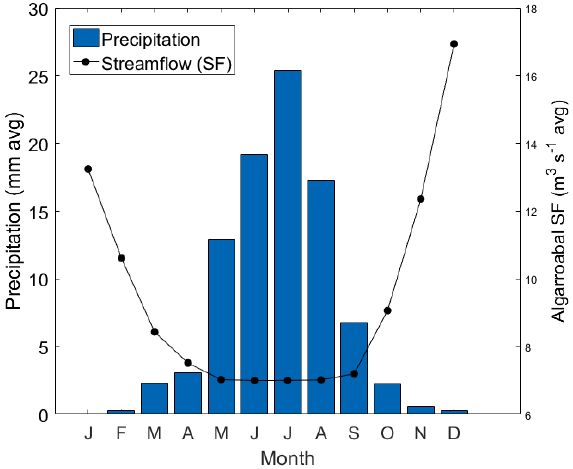
Figure 2. Annual cycle of average precipitation and streamflow (1950–2015).